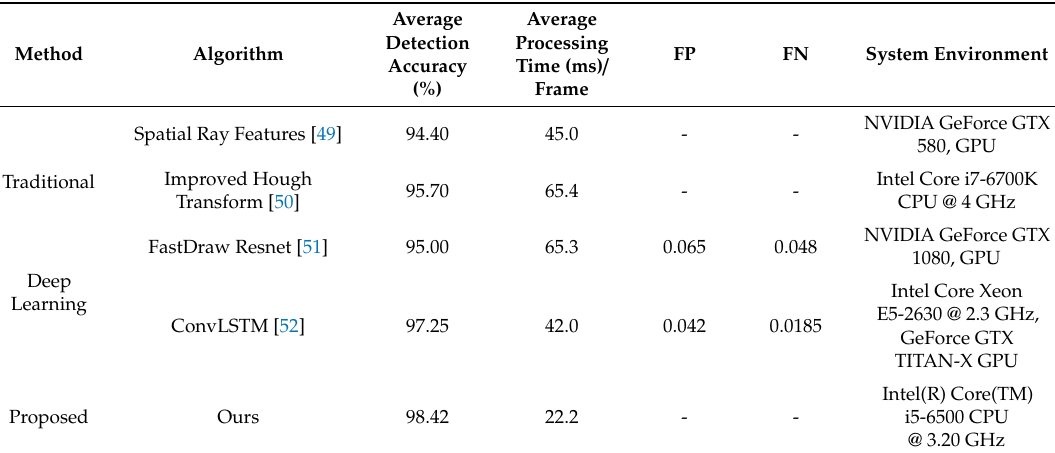
Table 3. The comparison of statistics in algorithms